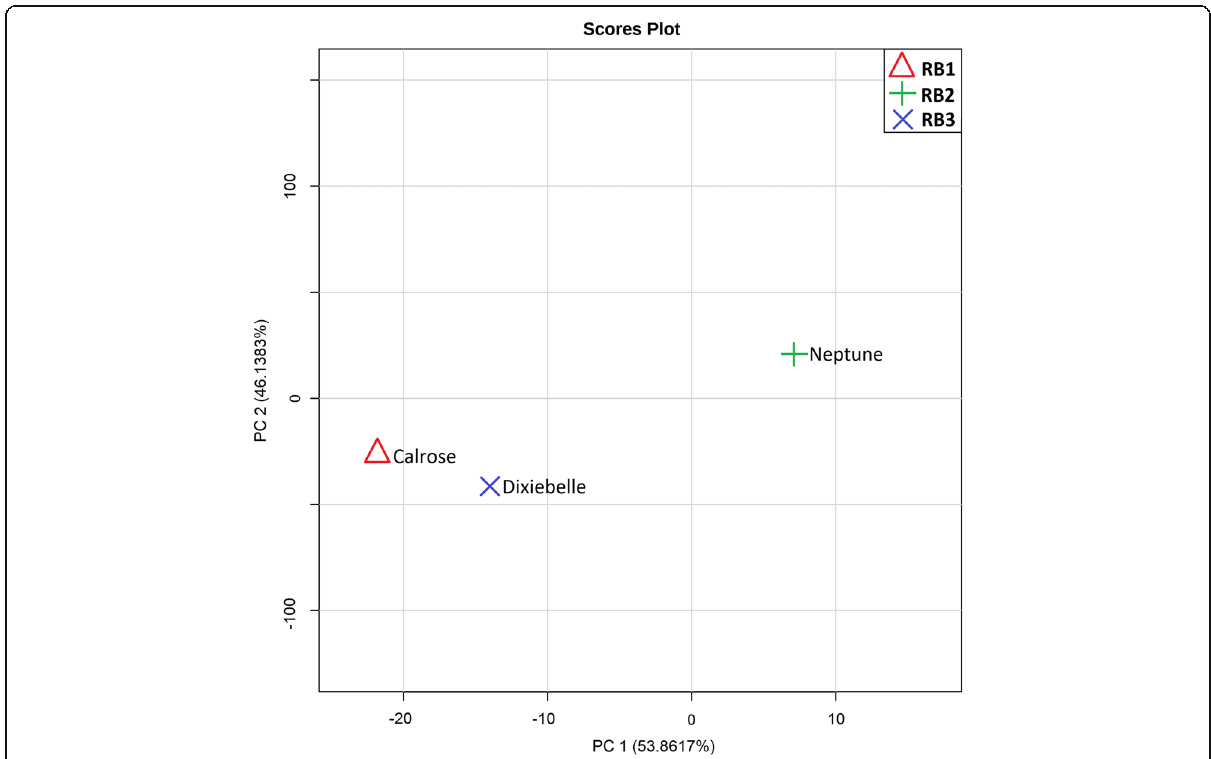
Fig. 5 Principal Component Analysis of three U.S. varieties. Principal component analysis (PCA) revealed that the first component described 54% variation herein and between separation of Calrose, Dixiebelle and Neptune rice bran cultivars. The second component describing 46% of the variance did not separate the varieties. No statistical significance was established between the metabolites detected from each of the three U.S rice varieties